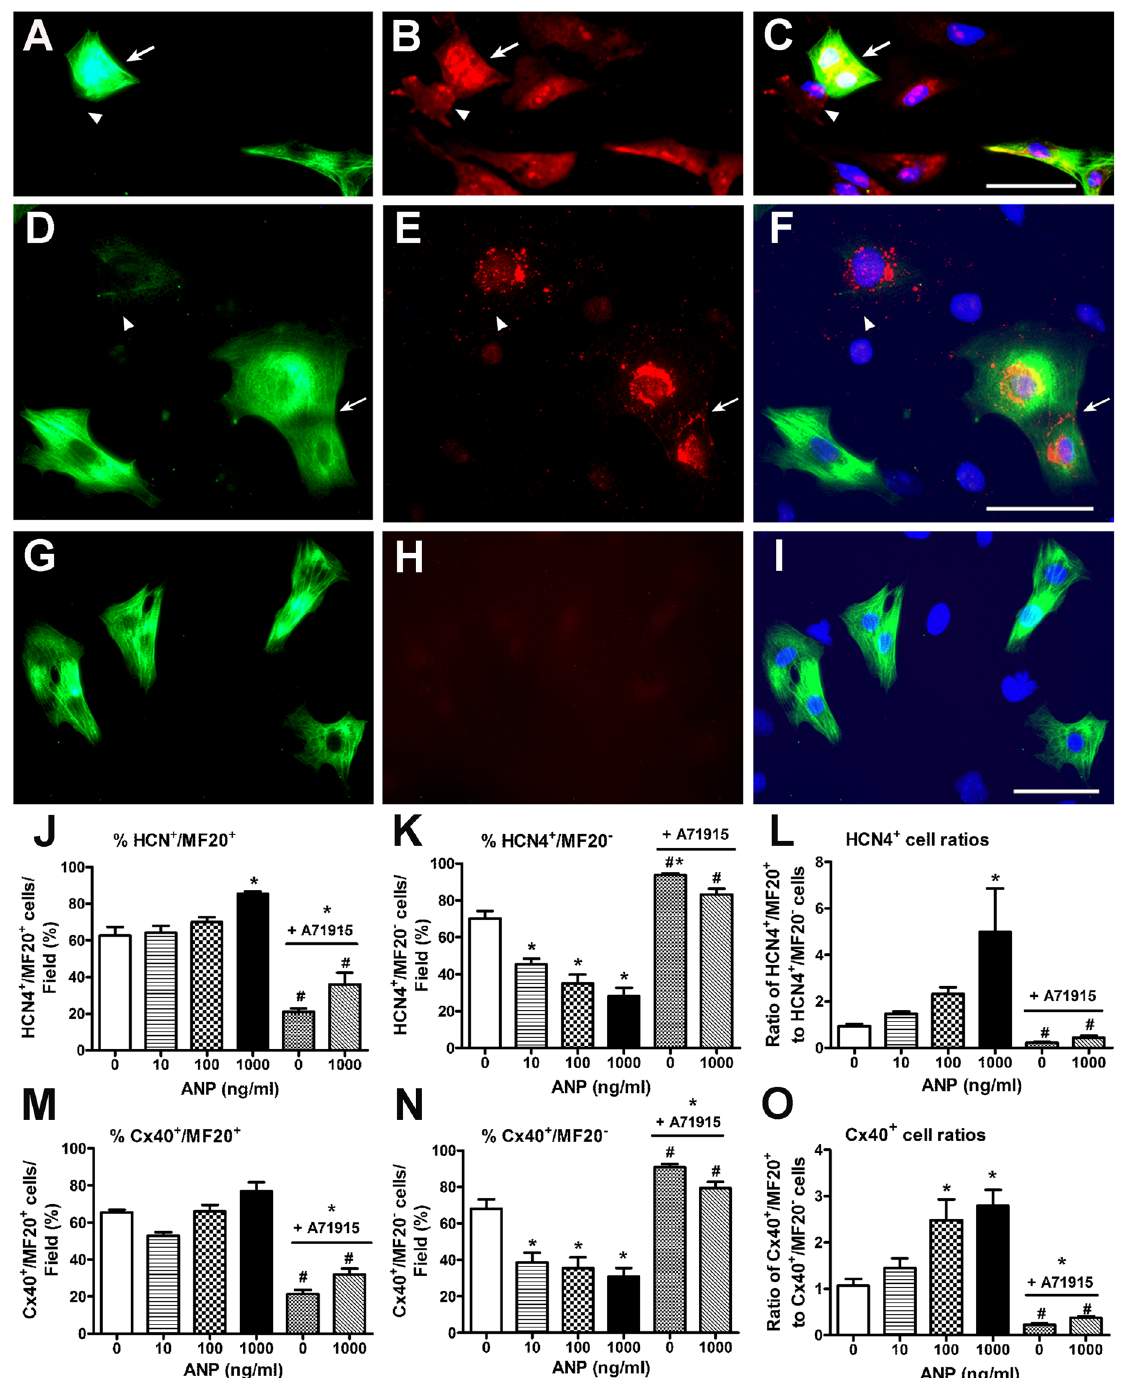
Figure 1. Quantification of HCN4 and Cx40 positive cells in E11.5 mouse ventricular cell cultures following addition of exogenous ANP and or NPRA inhibitor. ( A – C ) Representative images of cells co-stained with sarcomeric myosin, MF20 (A) and HCN4 (B) antibodies along with Hoechst nuclear stain (C). ( D – F ) Cells co-stained with MF20 (D) and Cx40 (E) antibodies. ( G–I ) Cells were co-stained with MF20 (G) and rabbit nonimmune IgG (H) antibodies. Overlays of immunostaining signals with Hoechst staining were shown in panels C, F and I. Arrows indicate HCN4 + or Cx40 + /MF20 + cardiomyocytes, arrow-heads indicate HCN4 + or Cx40 + /MF20 − nonmyocytes/VCS progenitor cells. A-I: scale bars = 50 μ M. ( J–O ) Percentage distribution and ratios of HCN4 + /MF20 + and HCN4 + /MF20 − cells (J–L) or Cx40 + /MF20 + and Cx40 + /MF20 − cells ( M – O ) in E11.5 mouse ventricular cell cultures treated with ANP (0, 10, 100 and 1000 ng/ml) and or NPRA inhibitor A71915 (1 µ M). N = 5 independent experiments, ~600–900 cells were counted for each group. Each bar represents mean ± SEM, * P < 0.05 Vs. 0 ng/ml (control), # P < 0.05 Vs. ANP (1000 ng or 1 µ g/ml) for each panel in J–O, One-way ANOVA with Tukey’s multiple comparisons post hoc